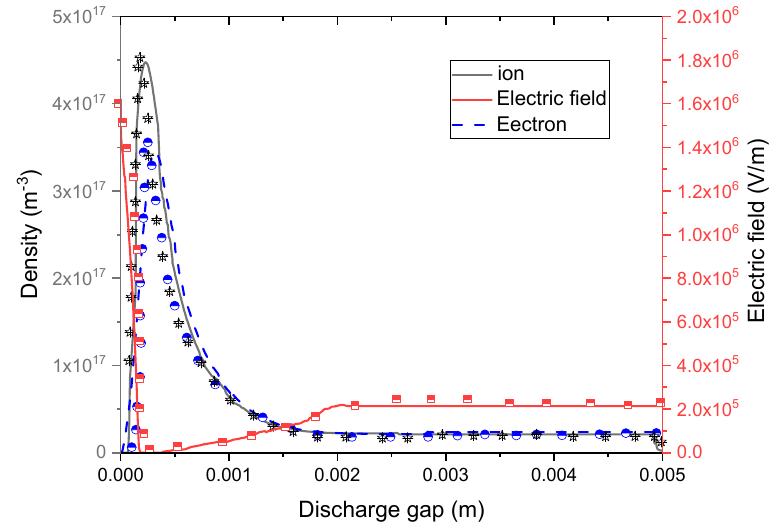
Figure 4. Comparison of calculated and experimental data [50]. Spatial distribution of the electron and ion densities and the electric field in helium plasma at a maximum discharge current time. The right side indicates the anode, and the left side indicates the cathode. In this zone, limited to 0.3 mm, the ion density reached a maximum of 4.7 × 10 17 m − 3 . The electron density attained a maximum of 3.6 × 10 17 m − 3 ; (ii) a second negative-glow region extending up to 0.73 mm in length, in which the densities of electrons and ions were equal, and the electric field remained small; (iii) the faraday dark space, with 1.4 mm thickness, where the ion and electron densities were in close proximity to each other as the electric field increased. Here, a little negative space charge occurred; (iv) a positive-column zone, occupying the greatest area, whose width was 2.58 mm. In this electrically neutral plasma region, the ion and electron densities were equal and close to 2 × 10 16 m − 3 . The electric field was relatively low, corresponding to 2 kV/cm. The electron mobility was reduced by the interaction with the ions. maximum discharge current. The metastable density distribution showed a profile similar to the ion and electron density profiles. During the cathode-fall region, a maximum density of 6.3 × 10 17 m − 3 was reached, while in the positive-column region, it was constant, with a value of 2 × 10 16 m − 3 .